Question: Express in one sentence what the figure is showing.
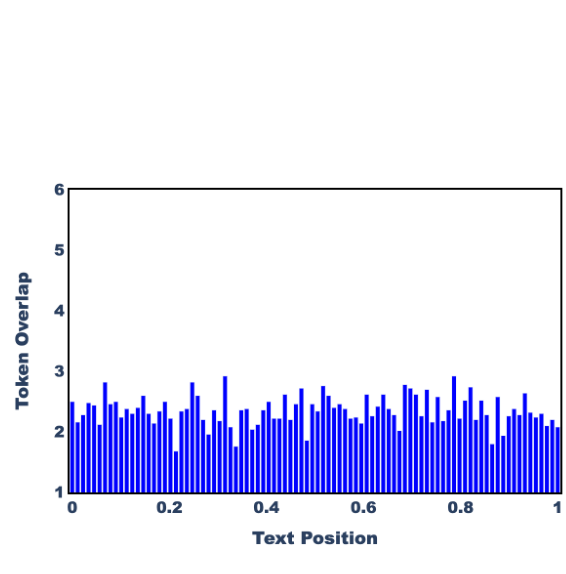
Answer: Average token overlap between human-written reference summaries and each document di using the DivSumm dataset. Text position on the x-axis has been normalized between 0 and 1.